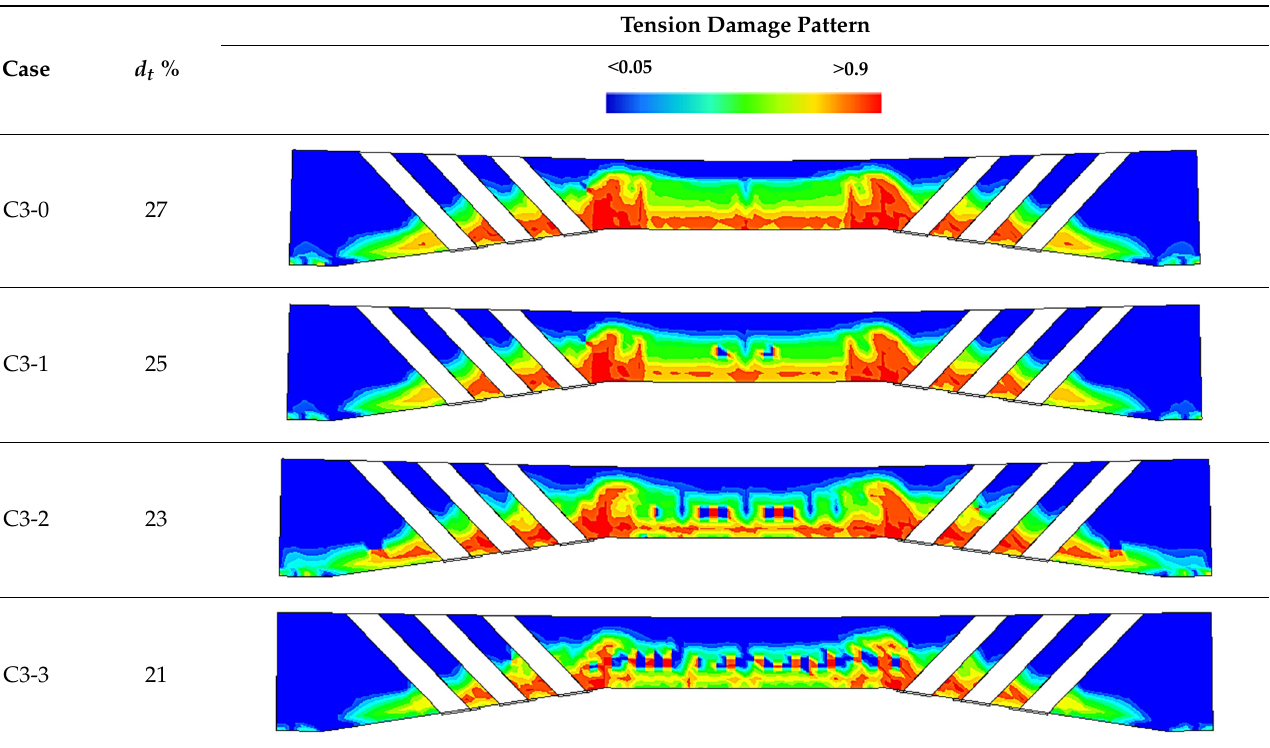
Table 5. Damage representation for C3 Table 5. Damage representation for C3 model. Table 5. Damage representation for C3 model. Table 5. Damage representation for C3 model. Table 5. Damage representation for C3 model. Table 5. Damage representation for C3 model.